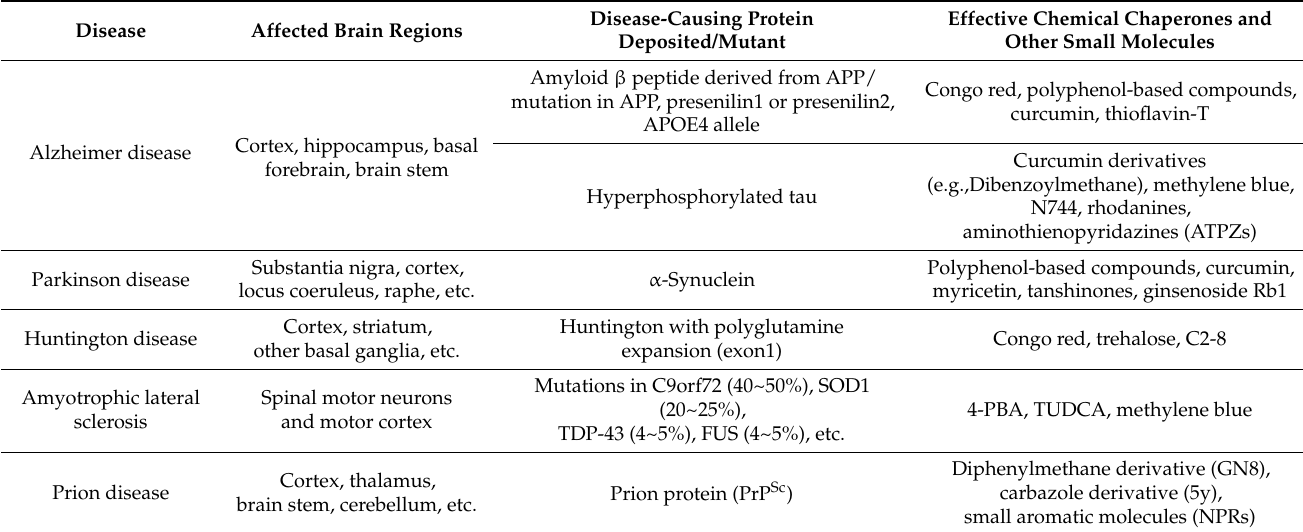
Table 1. Chemical chaperones and other small molecules targeting pathogenic protein